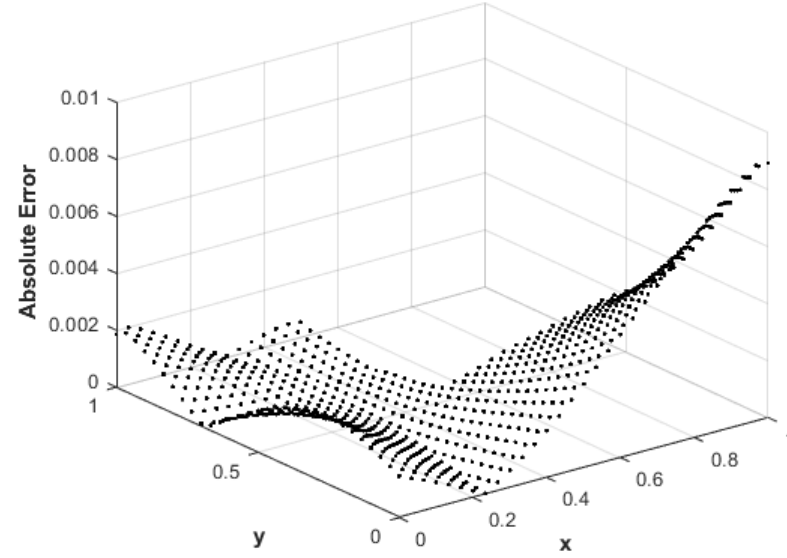
Figure 5. Absolute error using Robin boundary conditions in the L-shaped domain, with α = 0.5, γ 1 = 0.75, γ 2 = 0.95, N = 736, n = 73, and M =